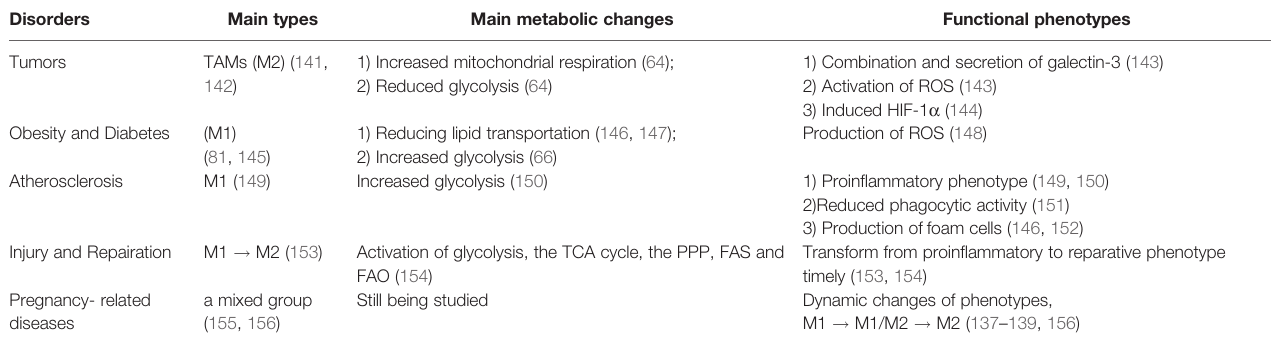
TABLE 3 | Association between disorders and metabolism and function in